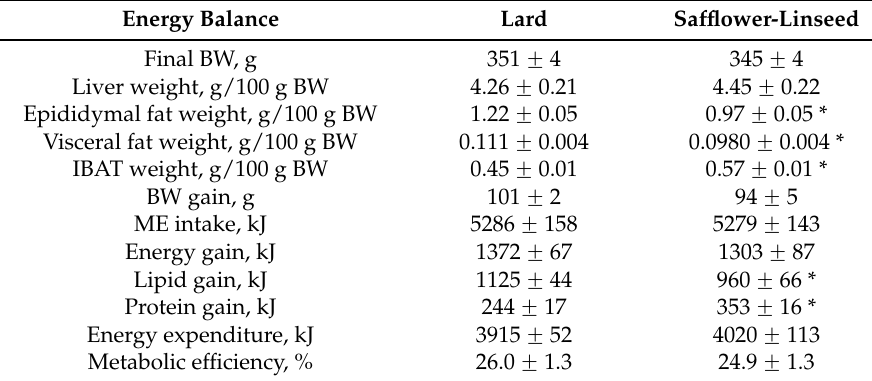
Table 2. Energy balance in rats fed lard or safflower-linseed high fat diet. Energy Balance